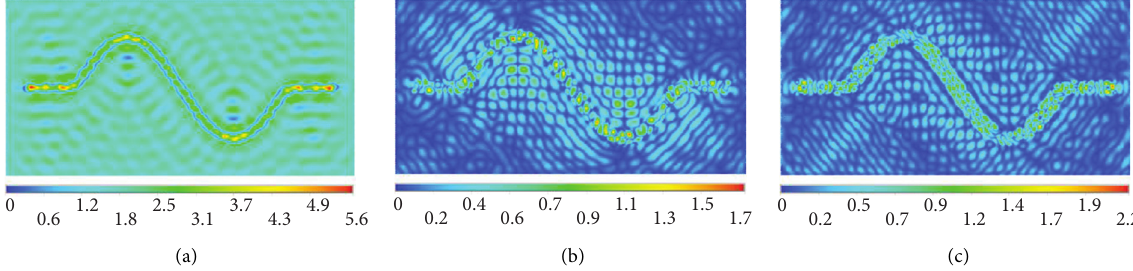
Figure 24: SV wave incident ( f � 5.0Hz, H � 100m, C